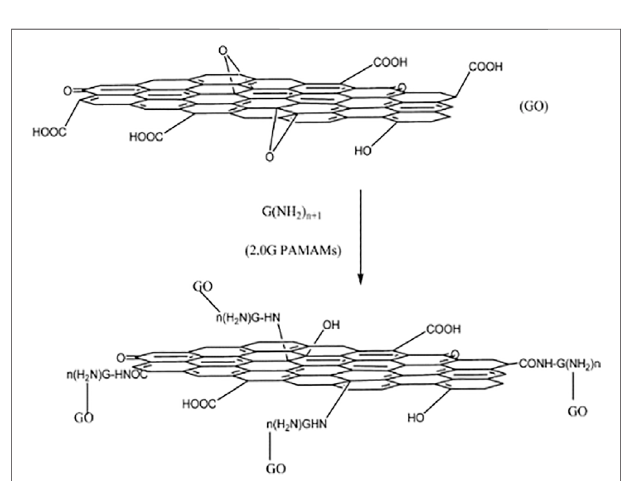
FIGURE 2 | Preparation of GO/PAMAMs